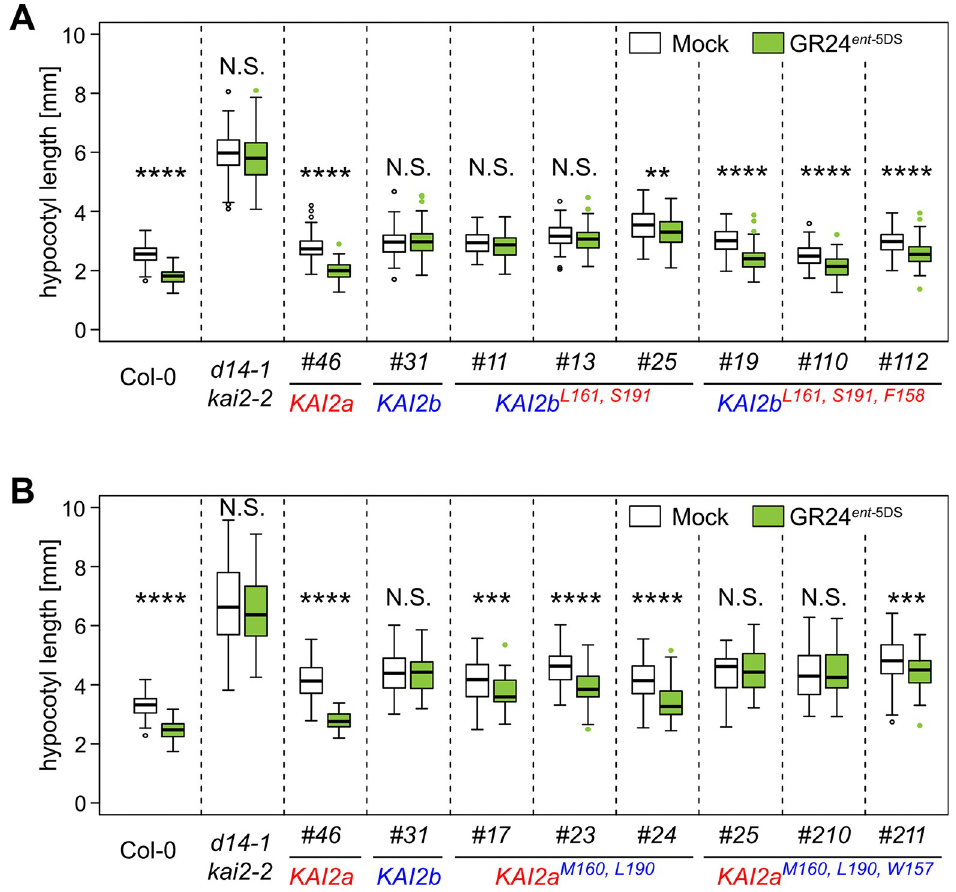
Fig 5. Amino acid swaps reverse sensitivity of Lj KAI2a and Lj KAI2b to GR24 ent- 5DS in Arabidopsis hypocotyls. Hypocotyl length of A . thaliana Col-0 wild-type, d14-1 kai2-2 double mutants, and d14-1 kai2-2 lines complemented with LjKAI2a and LjKAI2b variants driven by the AtKAI2 promoter and after treatment with solvent (Mock), 1 μ M GR24 5DS or GR24 ent -5DS . ( A ) LjKAI2a M160 , L190 and LjKAI2a M160 , L190 , W157 (n = 46–84). ( B ) LjKAI2b L161 , S191 and LjKAI2b L161 , S191 , F158 (n = 49–102). ( A-B ) Seedlings were grown in 8h light/16h dark periods Asterisks indicate significant differences versus mock treatment (Welch t.test, � � 0.05, �� � 0.01, ��� � 0.001, ���� �